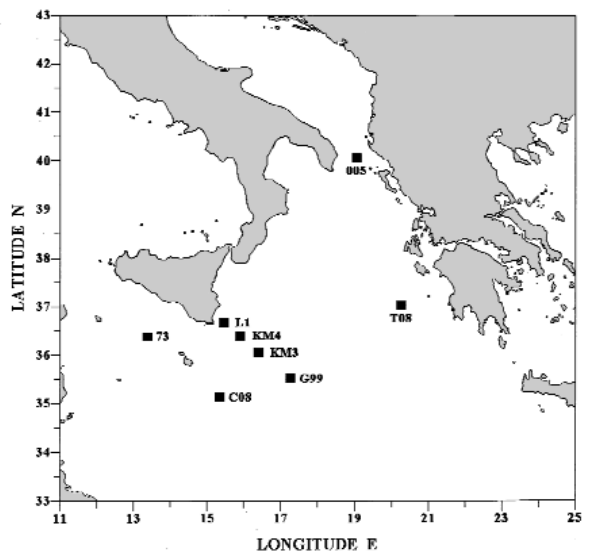
F IG . 1. – Map of the Ionian Sea showing the stations sampled from surface to the bottom depth (maximum 4000 m) during the TALASTRO-4 and SINAPSI-3